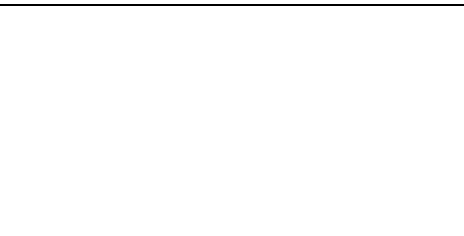
Table No. V : Comparision